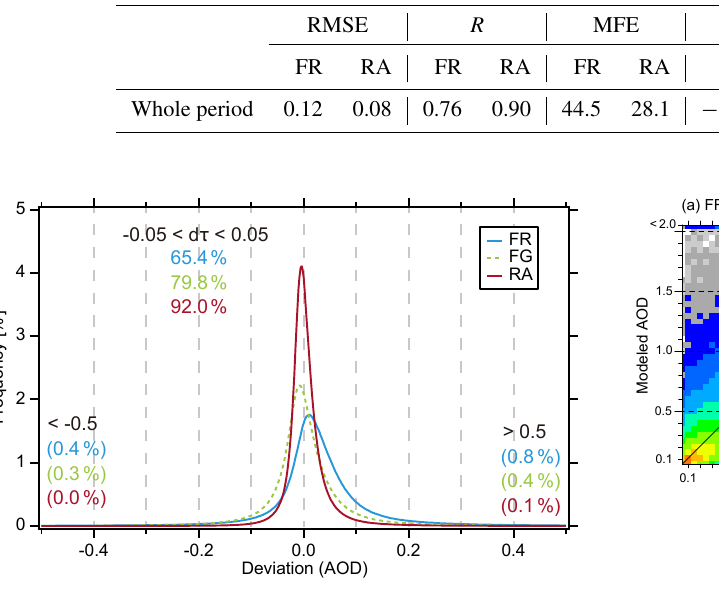
Figure 10. Frequency distributions of deviations (observed AODs minus modeled AODs) from the NRL-UND MODIS AODs. The percentages of deviations between − 0.05 and + 0.05 are shown at the top, and the percentages less than − 0.5 (bottom left) or greater than + 0.5 (bottom right) are shown in parentheses.